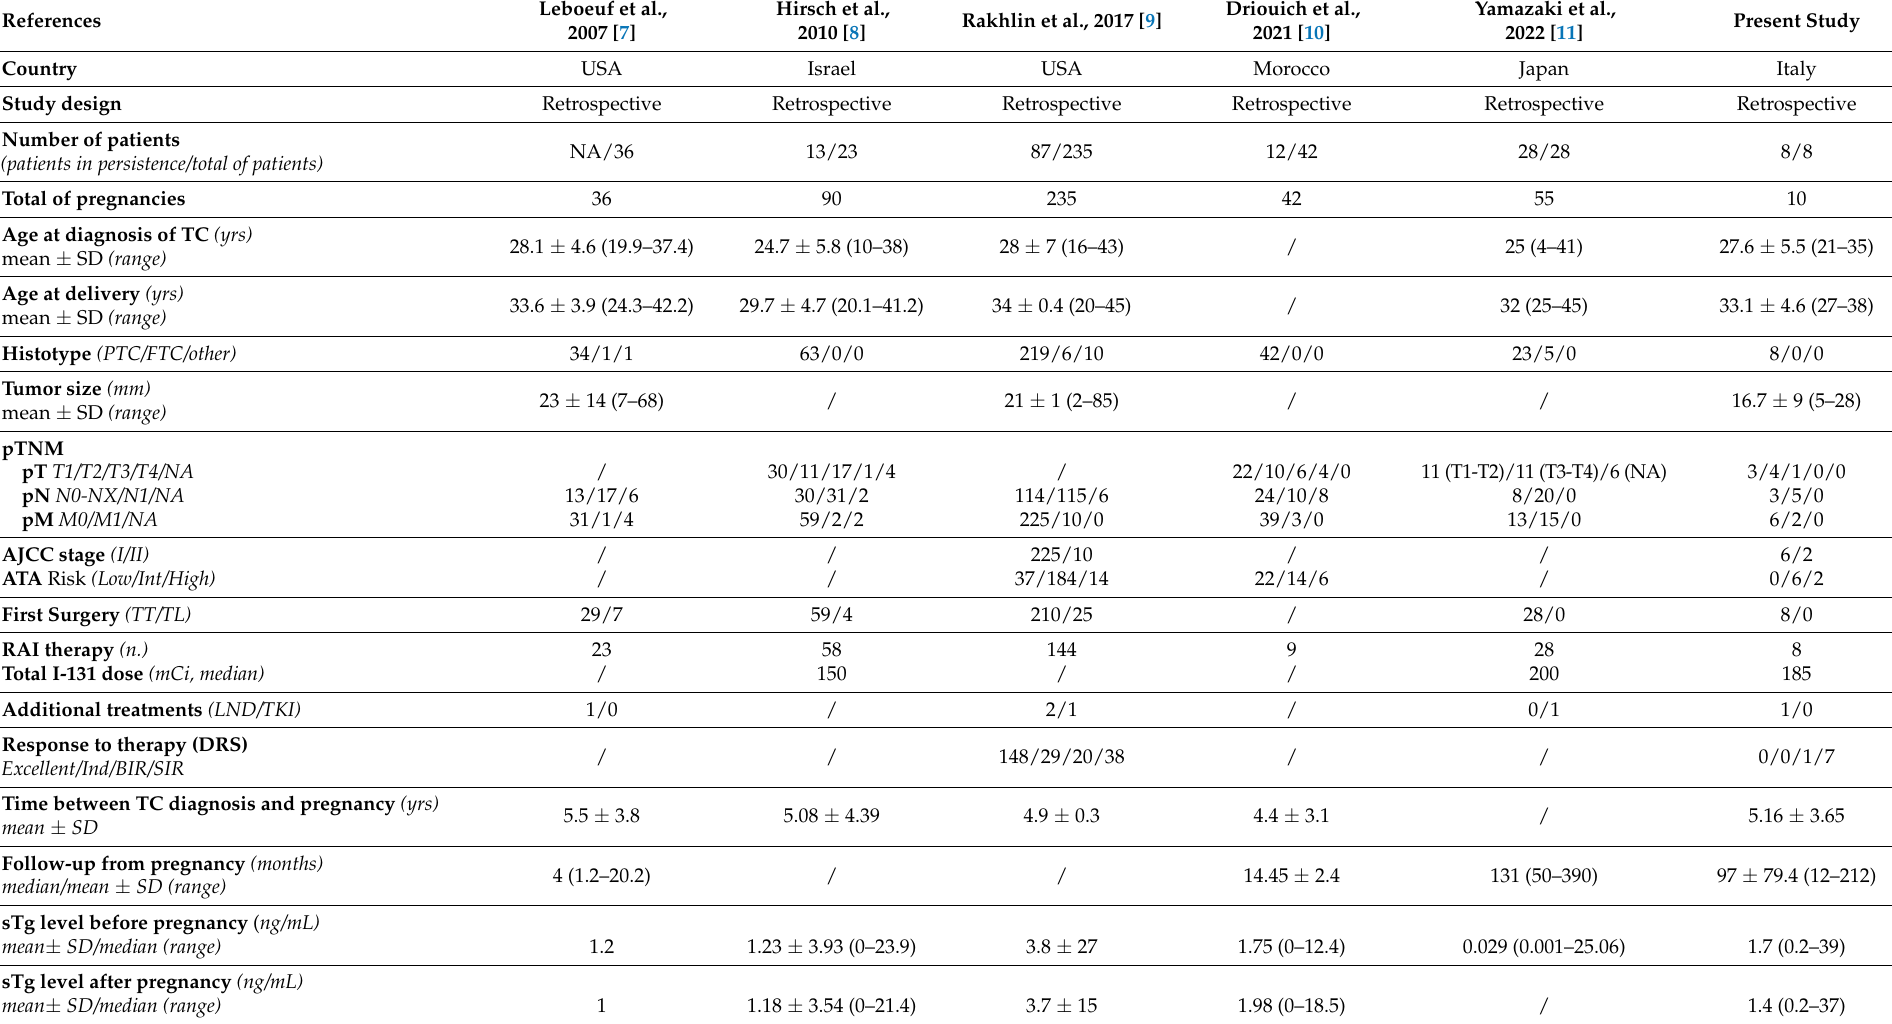
Table 3. Revision of clinical studies published to date on DTCs patients in disease persistence before